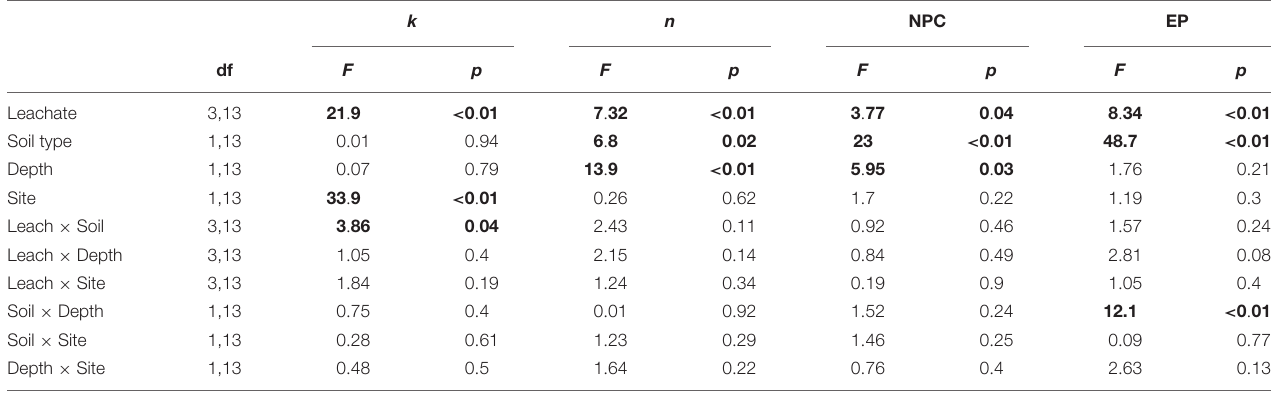
k and n are curve fitting parameters. NPC, null point concentration; EP, endpoint.